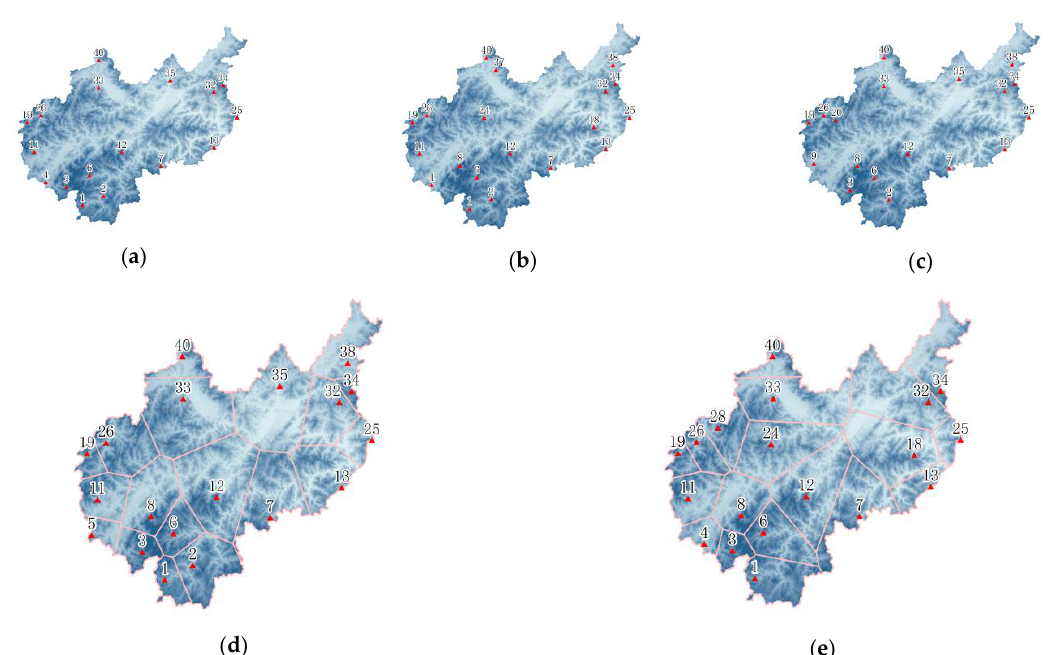
Figure 8. Optimized design results for 40 existing rain gauge stations with five types of data. ( a ) optimized station network with GPM IMERGE Early data; ( b ) optimized station network with GSMaP_NRT data; ( c ) optimized station network with PERSIANN − CCS data; ( d ) optimized station network with the three sets of satellite-based data combination; ( e ) optimized station network with rain gauge